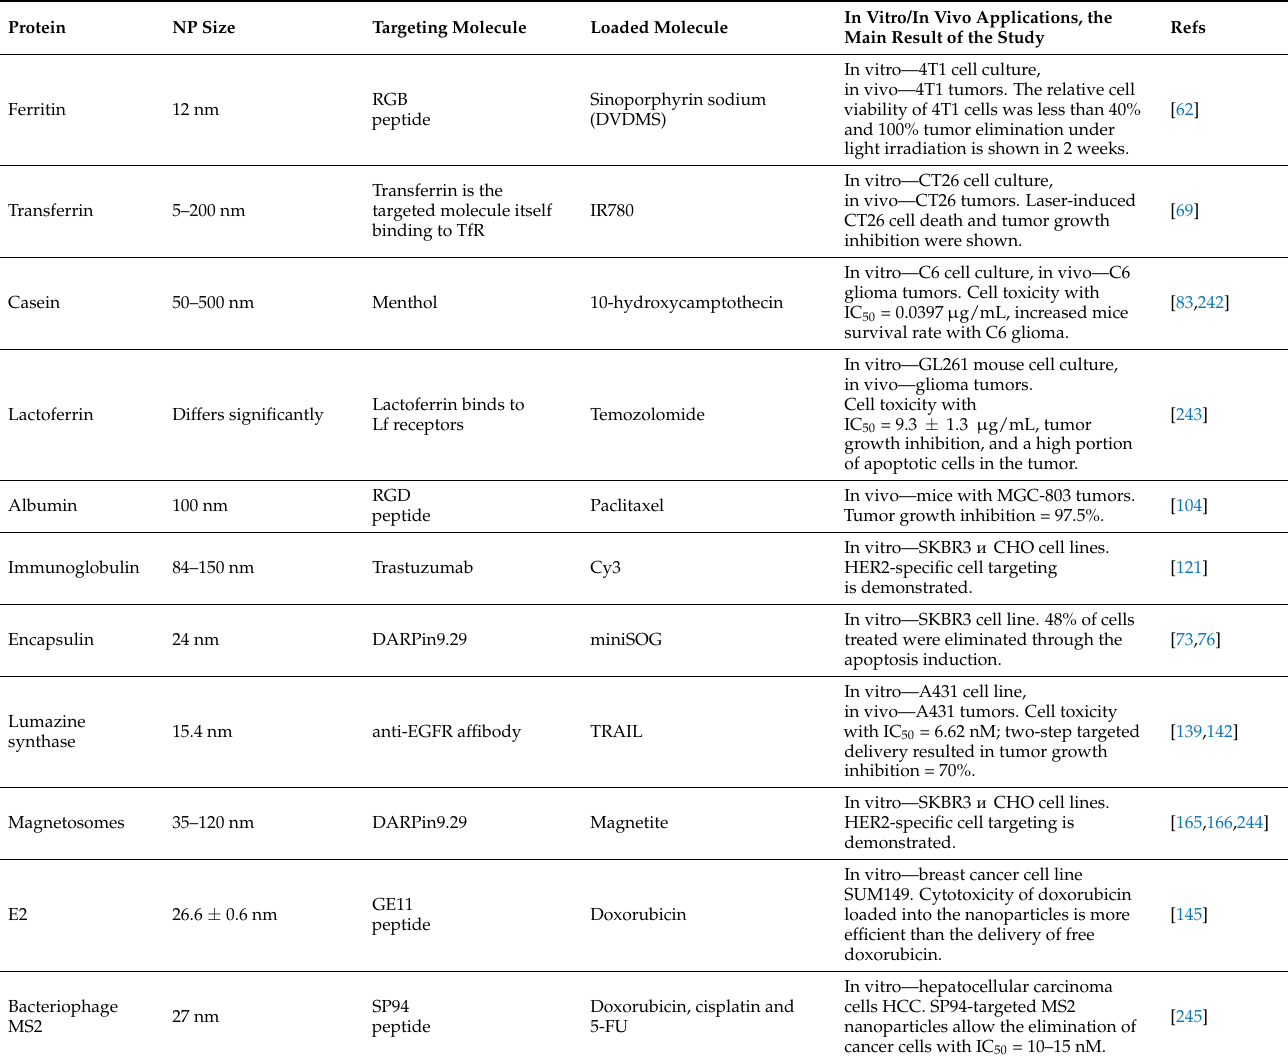
Table 1. Characteristics and application of targeted protein self-assembling